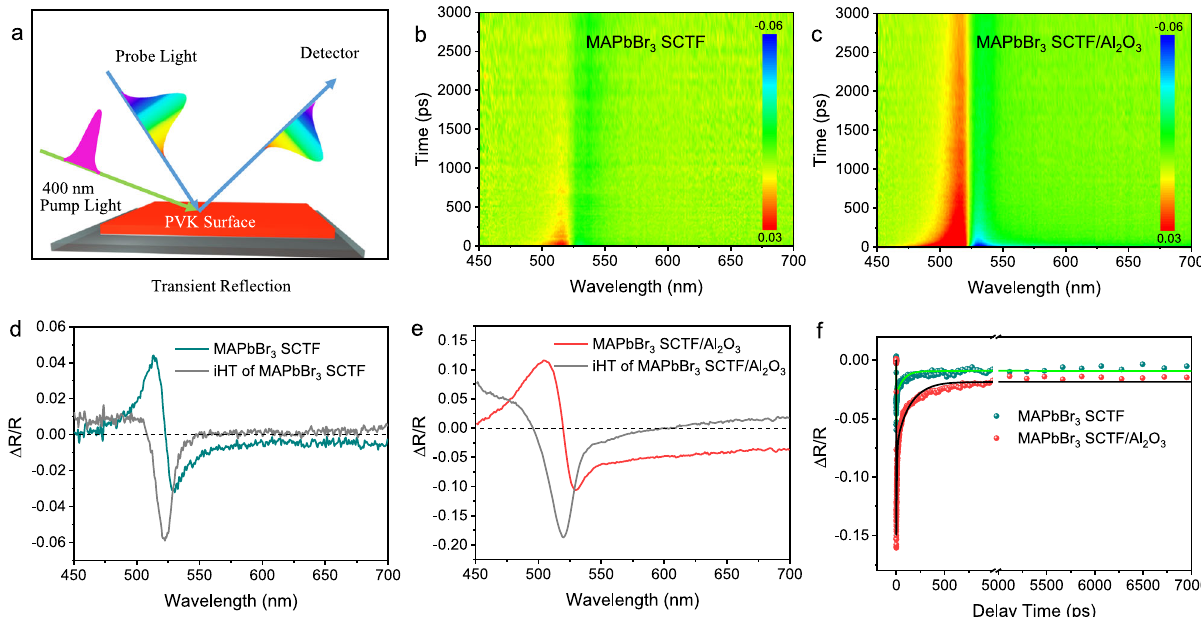
Fig. 4 Transient re fl ection spectroscopic measurements. a Diagram of transient re fl ection (TR); TR spectra pseudocolour images, and TR spectra recorded at a delay time of 5 ps of pristine MAPbBr 3 SCTF ( b , d ) and MAPbBr 3 SCTF/Al 2 O 3 ( c , e ). Kinetic fi t of the data of these two SCTFs ( f ). NATURE COMMUNICATIONS| (2021) 12:1202